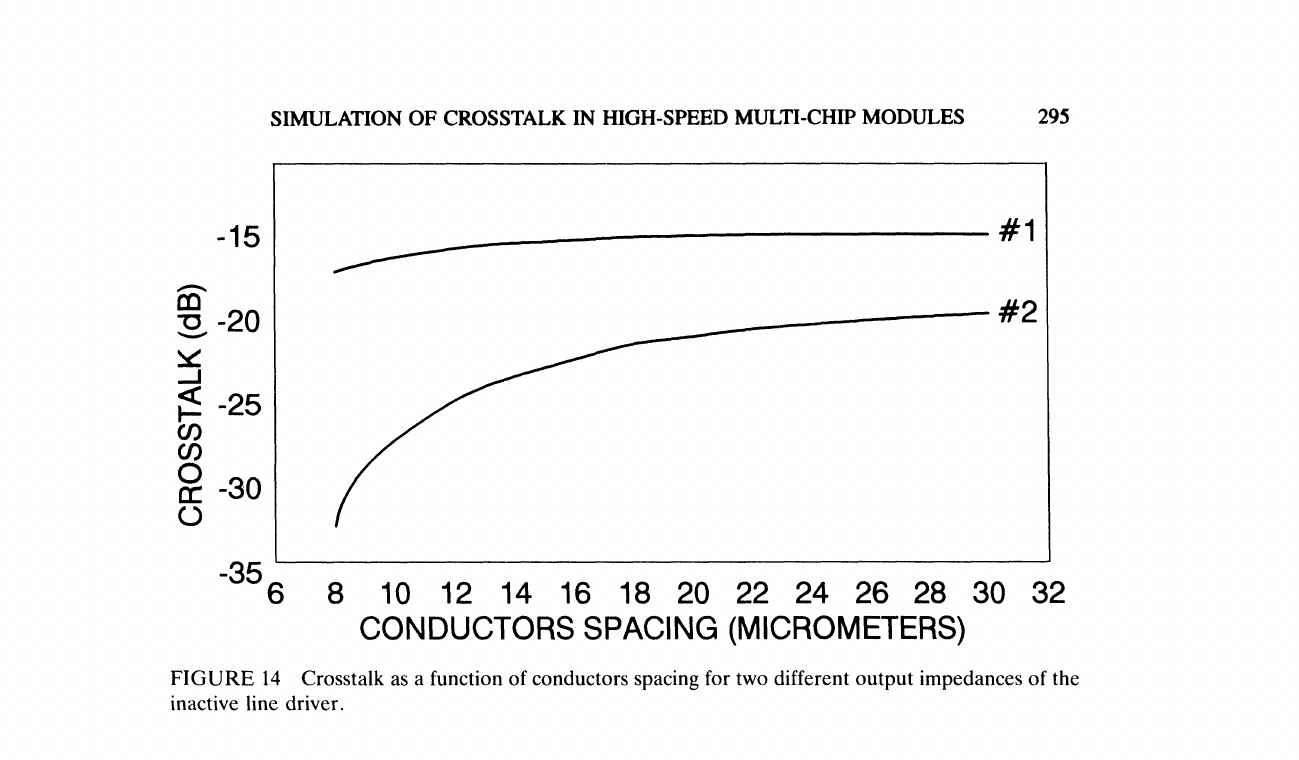
FIGURE 14 Crosstalk as a function of conductors spacing for two different output impedances of the inactive line driver.